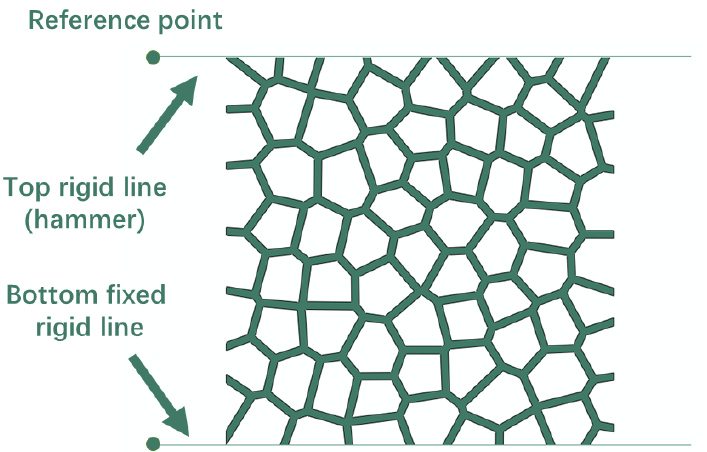
Figure 2. Two-dimensional Voronoi foam specimens with different porosities and their cell size distributions ( a ) 73.0%, ( b ) 85.7%.